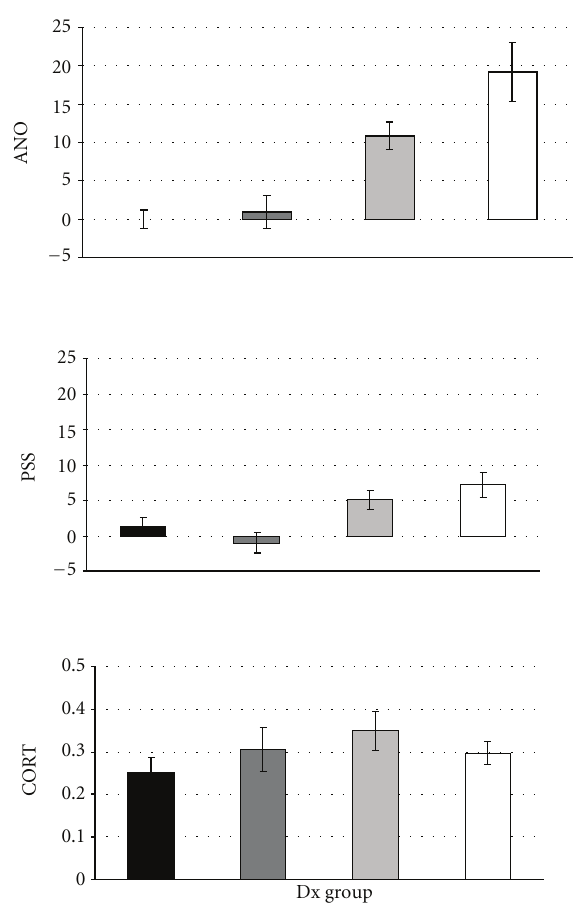
Figure 1: Scores on anosognosia for dementia, anosognosia for per- ceived stress, and cortisol levels in normal elderly, individuals with Mild Cognitive Impairment, newly diagnosed, and long-lasting Alzheimer’s disease patients. These graphs represent the scores on anosognosia for dementia (ANO), anosognosia for perceived stress (PSS), and cortisol levels (CORT, in μ g/dL) in 21 normal elderly (NE, black bars), 20 individuals with Mild Cognitive Impairment (MCI, dark grey bars), 12 newly diagnosed (new AD, light grey bars), and 17 long-lasting (old AD, white bars) Alzheimer’s disease patients.